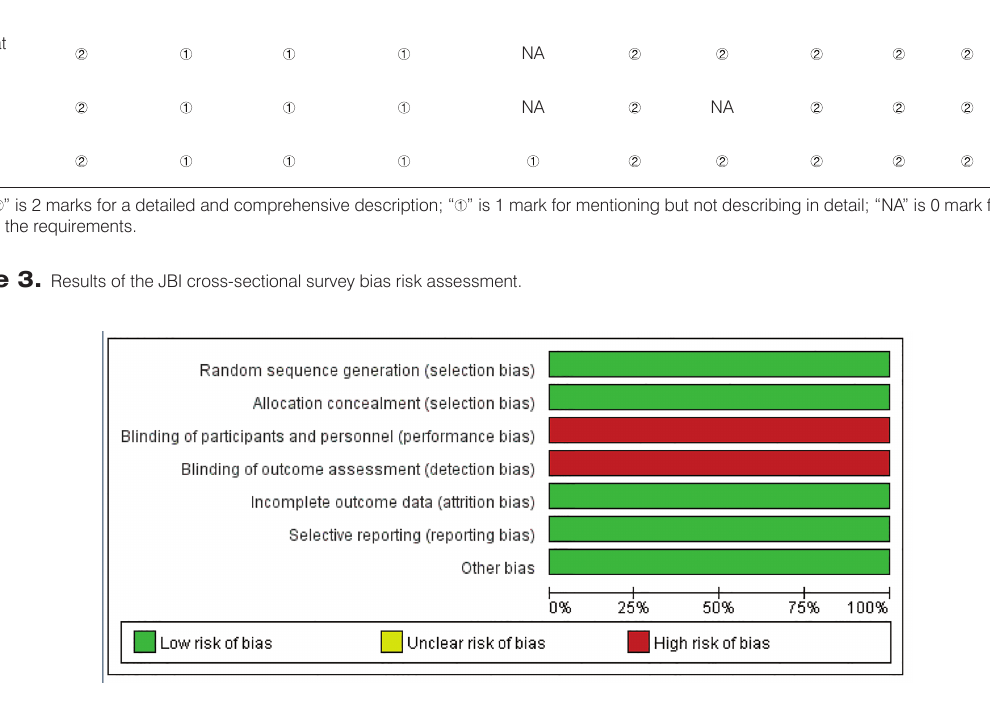
Figure 2. Results of risk bias evaluation of randomized controlled